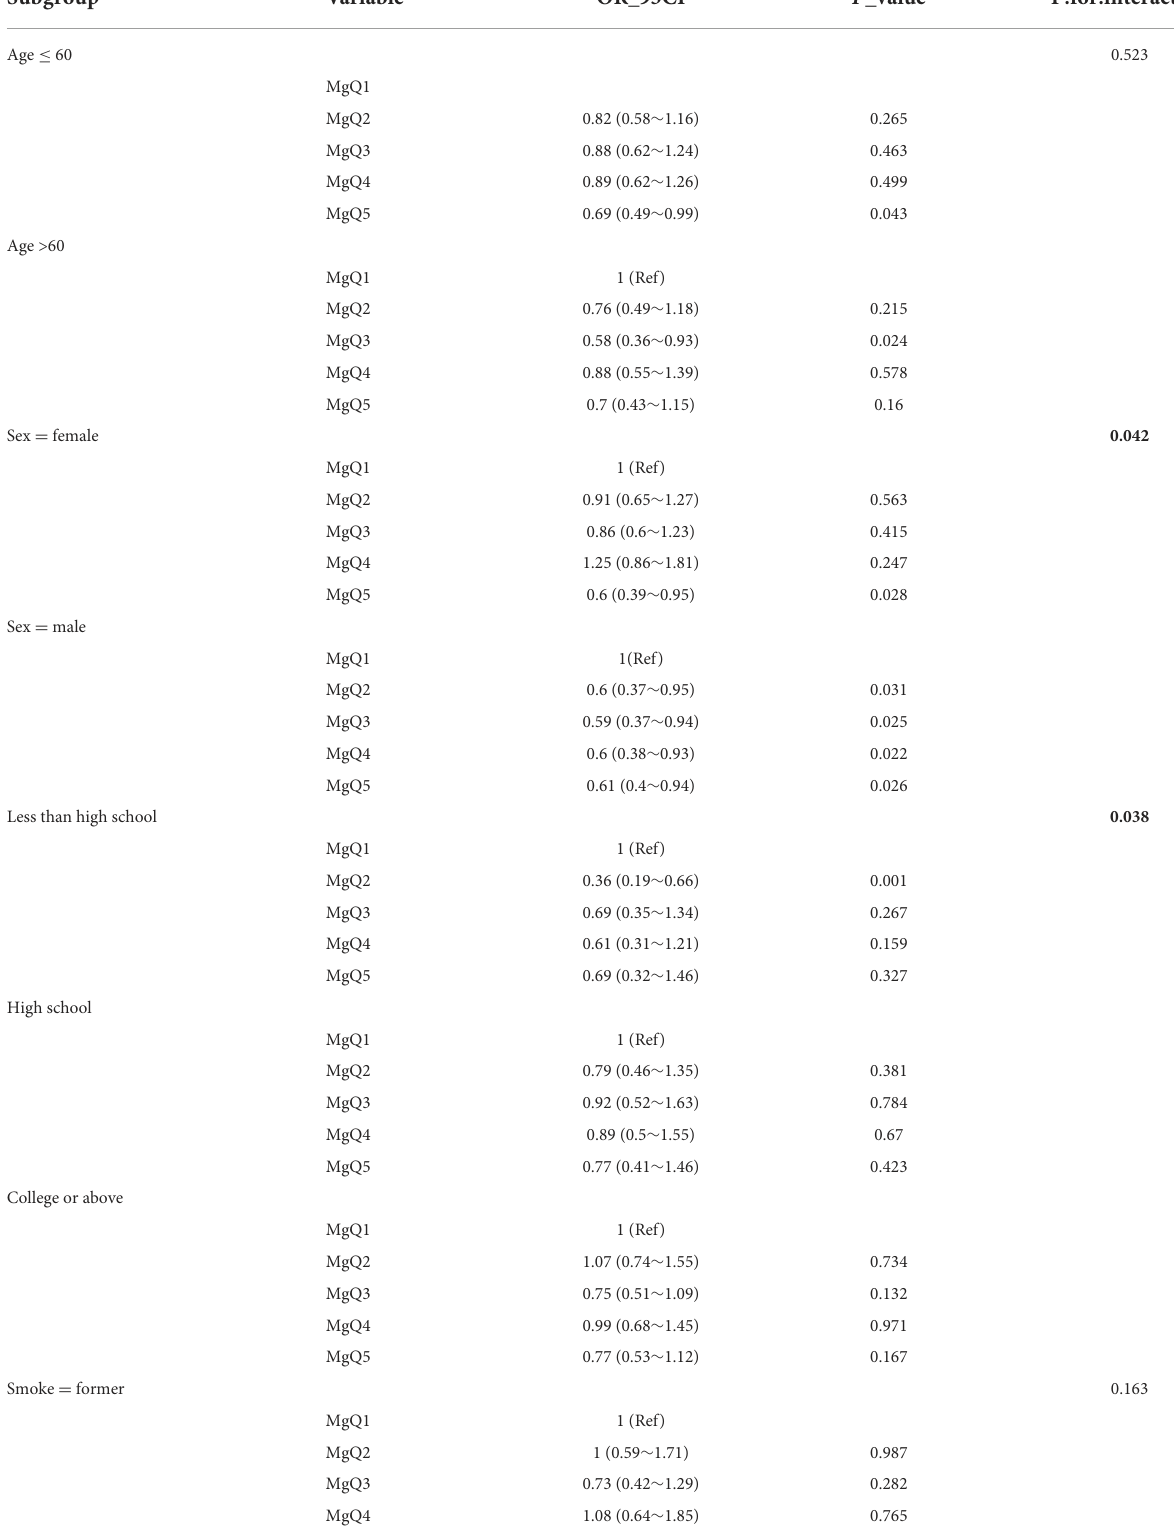
TABLE 3 Stratifiedlogistic regression analysis to identify variables that modify the correlation. Subgroup Variable OR_95CI P _value